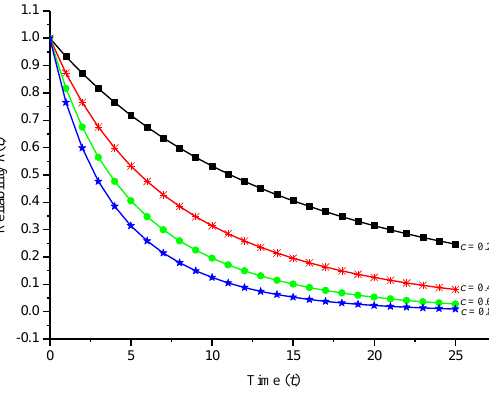
Figure 8. Reliability of the system with